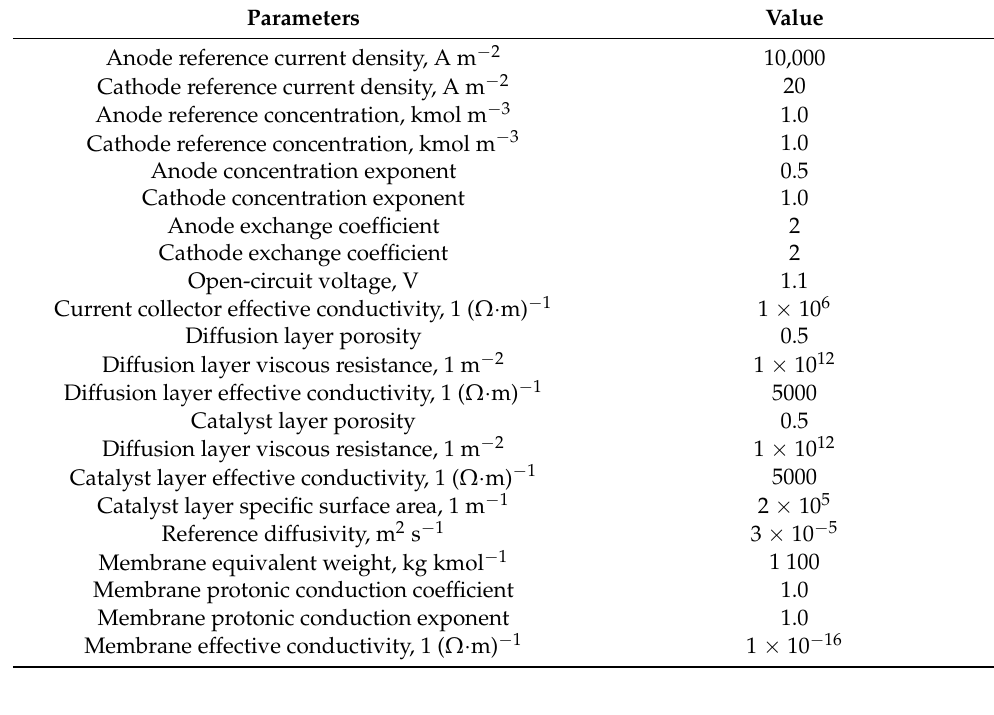
Table 2. Fuel cell parameters.